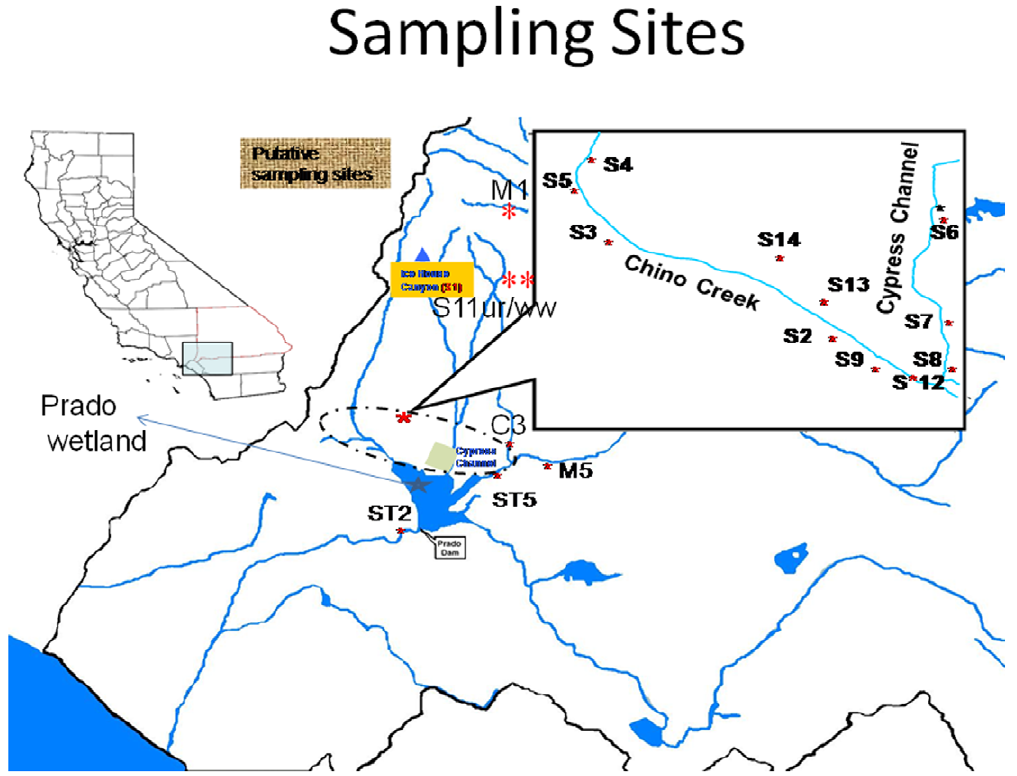
Figure 1. Sites used for the study along the MSAR watershed. Chino Creek and Cypress channel are the two main channels in the MSAR watershed with inputs from urban runoff and agricultural activities, respectively. Both creeks empty into the Santa Ana River.